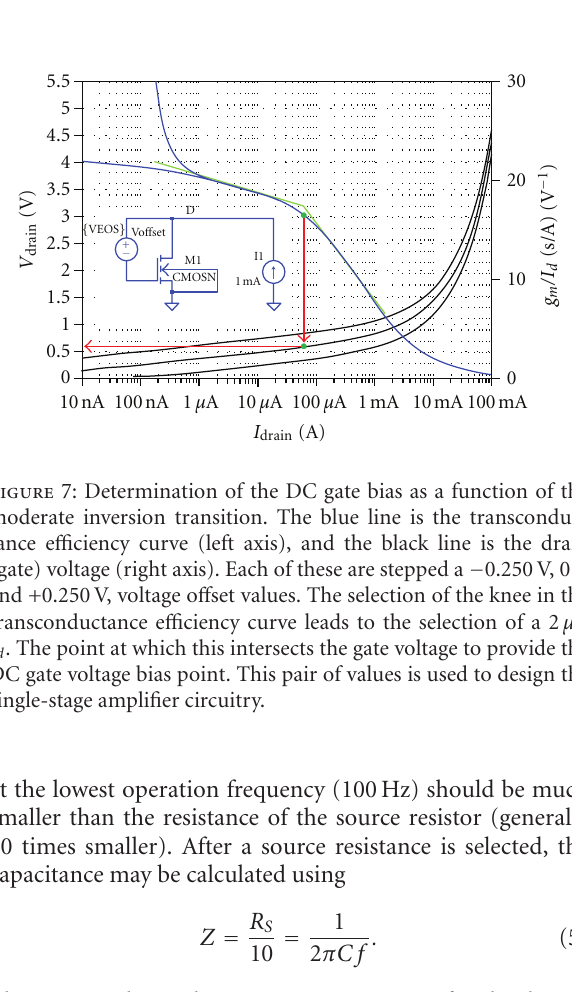
Figure 5: Theoretical transconductance e ffi ciency figure of merit graph. U T is thermal potential KT and n is the slope factor or body e ff ect factor.